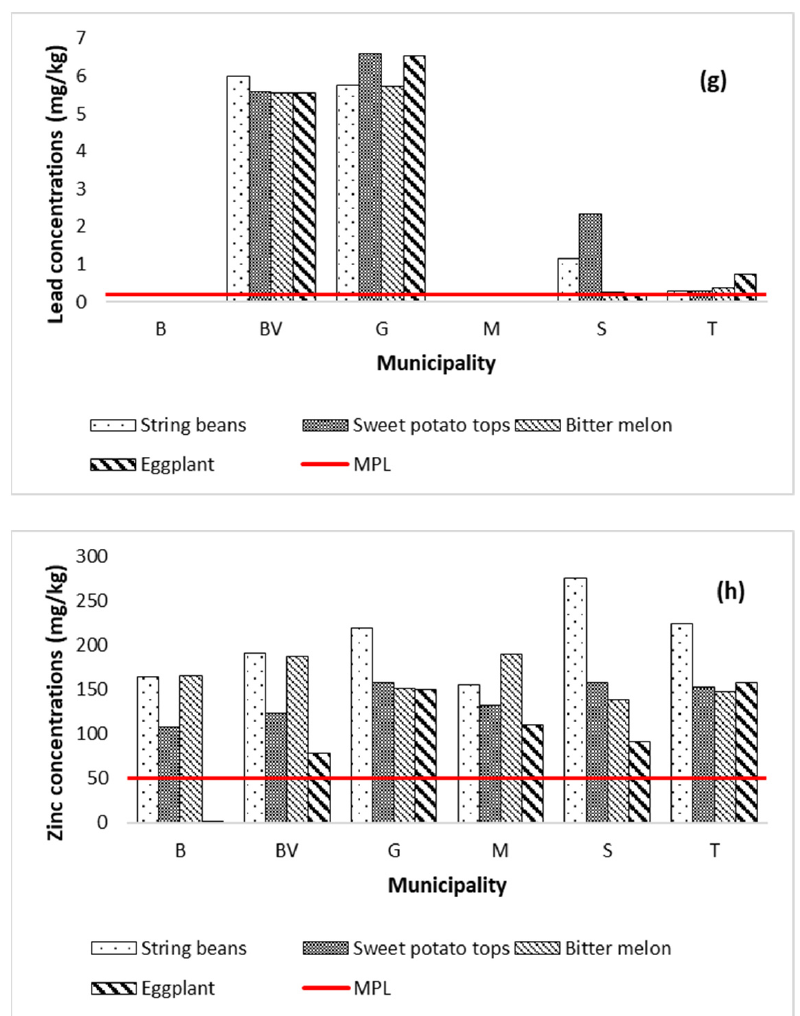
Figure 4. Metal concentrations in vegetables by municipality in the island province. The concentration of Cd ( a ) in all vegetables from BV and G was above MPL. The concentration of Cr ( b ) in vegetables from BV and G was above the MPL. The Cu concentration ( c ) in all vegetables was below MPL in all six municipalities. The Fe concentration ( d ) in all vegetables of the six municipalities except for the sweet potato tops of G was below MPL. The Mn concentration ( e ) in all vegetables from the six municipalities except the eggplant from B and M was beyond MPL. The Ni concentration ( f ) in string beans from BV and G and the sweet potato tops from Gasan exceeded the MPL. The Pb concentration ( g ) in all vegetables from BV, G, S, and T was beyond MPL. The Zn concentration ( h ) in all vegetables from the six municipalities except for the eggplant of B was above the MPL.